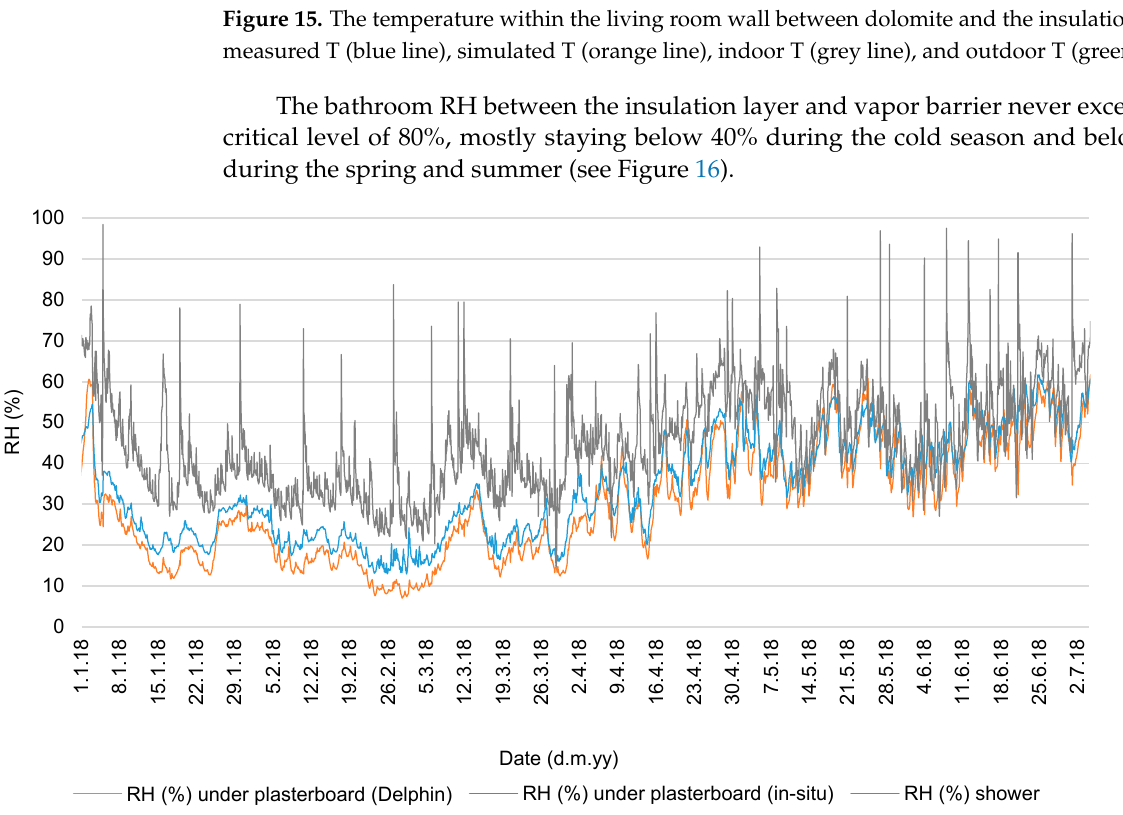
Figure 16. Relative humidity measurements of the bathroom wall between the insulation and vapor barrier: Measured RH (blue line), simulated RH (orange line), indoor bathroom RH (grey line). Temperature between the insulation and vapor barrier in the bathroom shows similar data for measured and simulated data, with simulated data being slightly higher and closer to the measured indoor air temperature (see Figure 17).